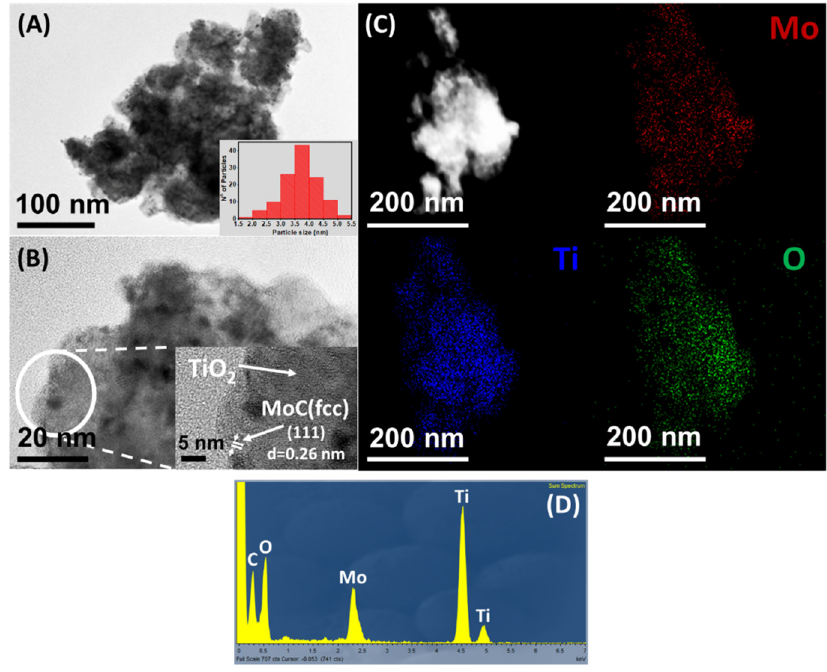
Figure 6. ( A , B ) TEM − HRTEM micrographs of Mo x C/TiO 2 catalyst; ( C ) STEM − EDX mapping; ( D ) EDX spectrum.